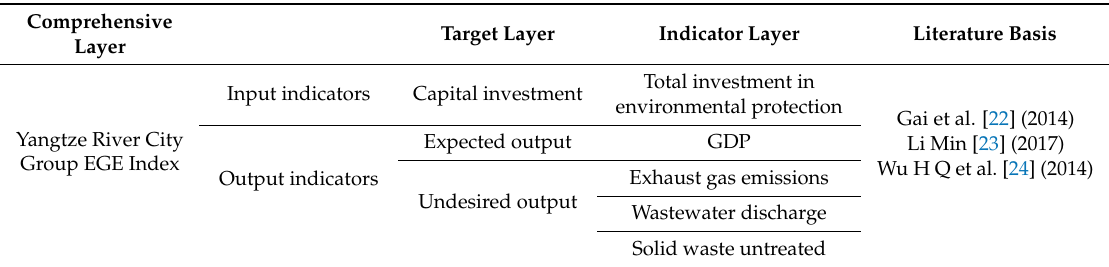
Table 1. Indicator system for Environmental Governance Efficiency (EGE) of the Yangtze River urban agglomeration.